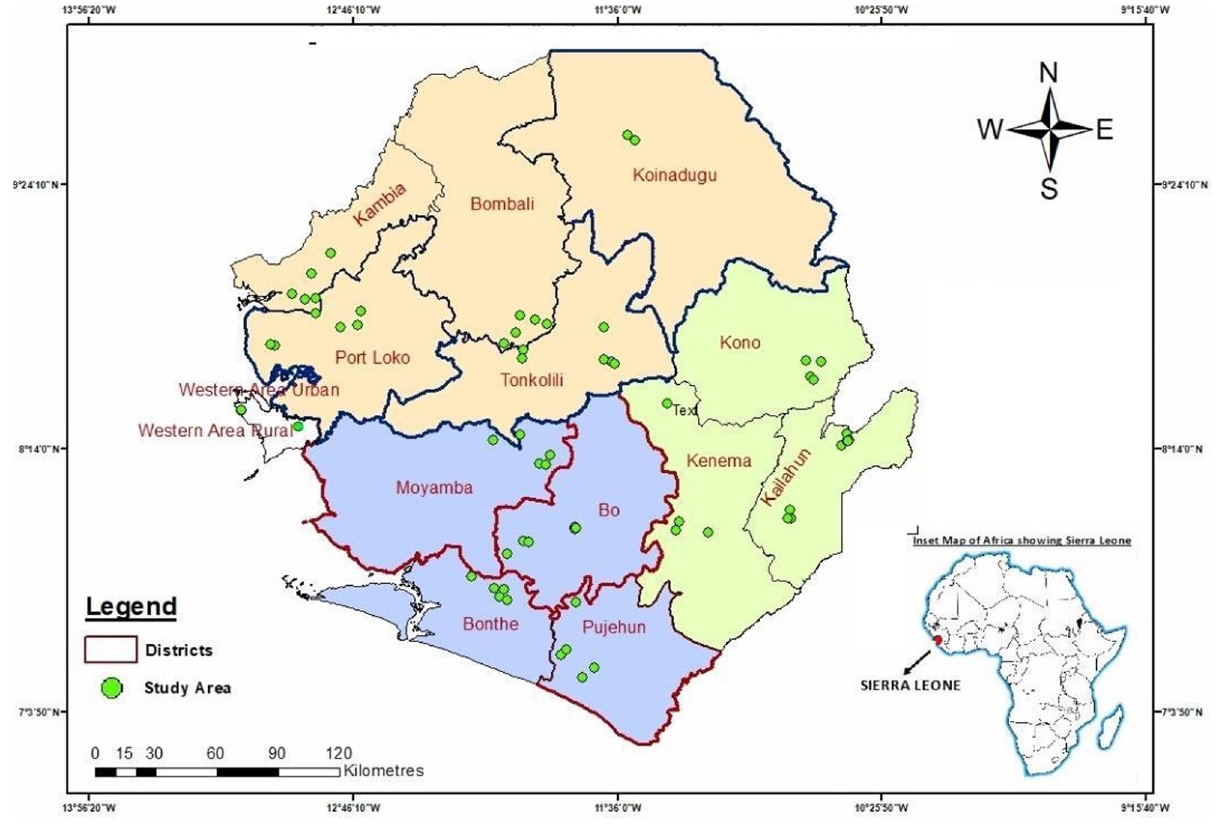
Figure 1: Maps of Sierra Leone indicating data collection locations. Source: Authors ’ survey,